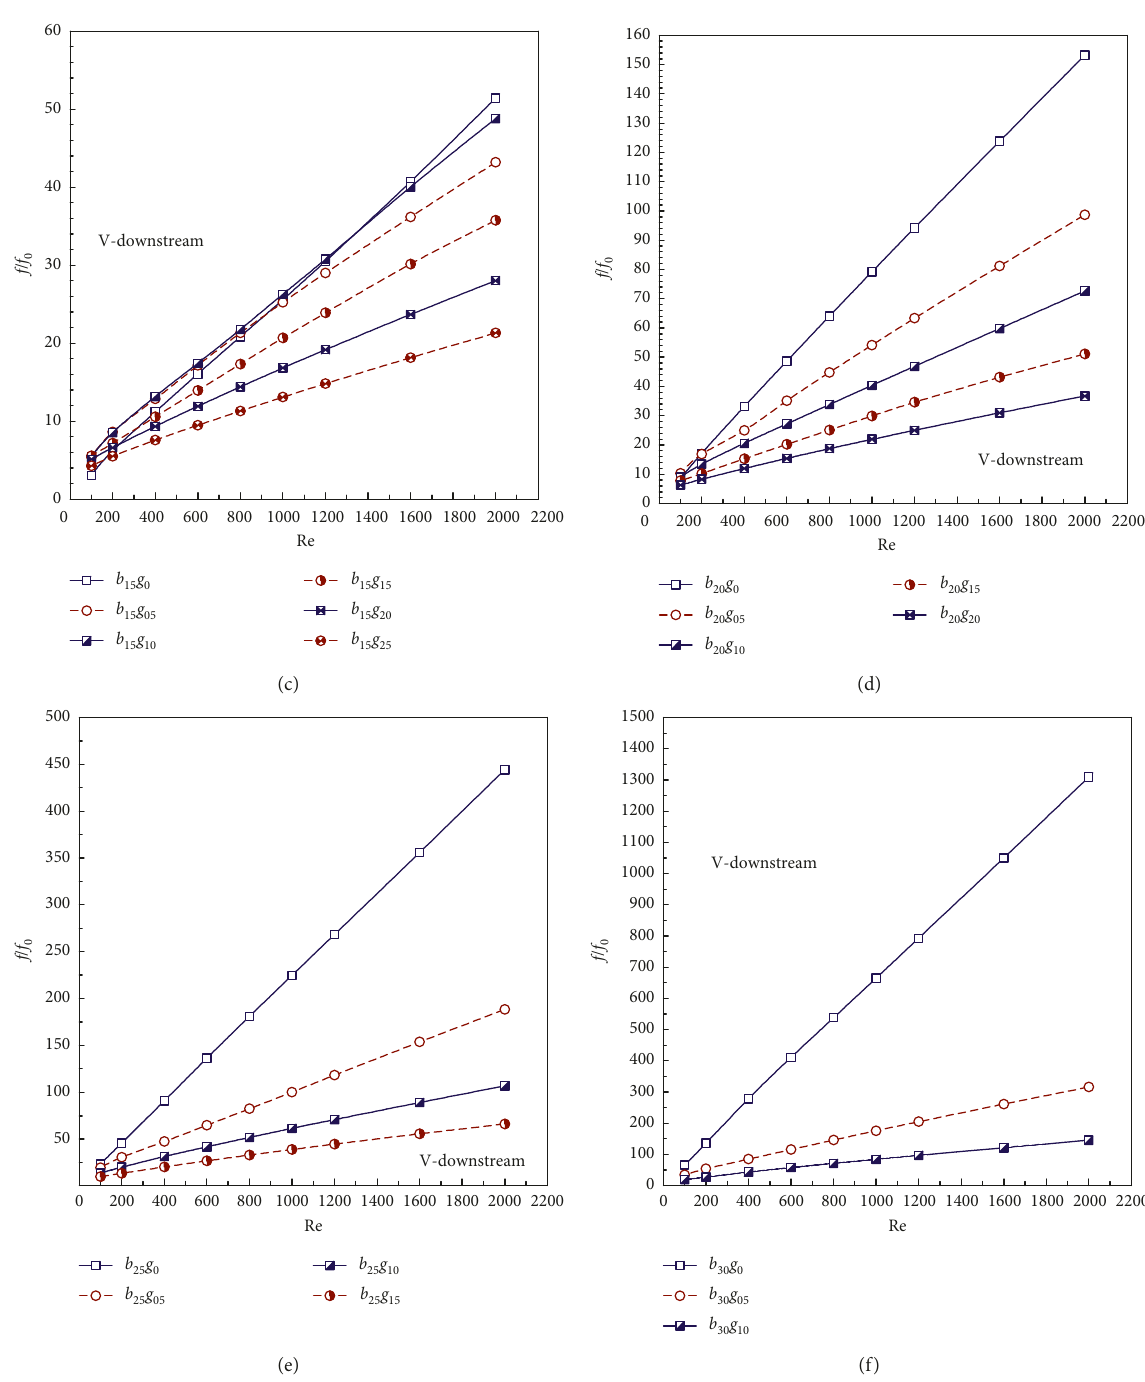
Figure 13: Relation of f / f